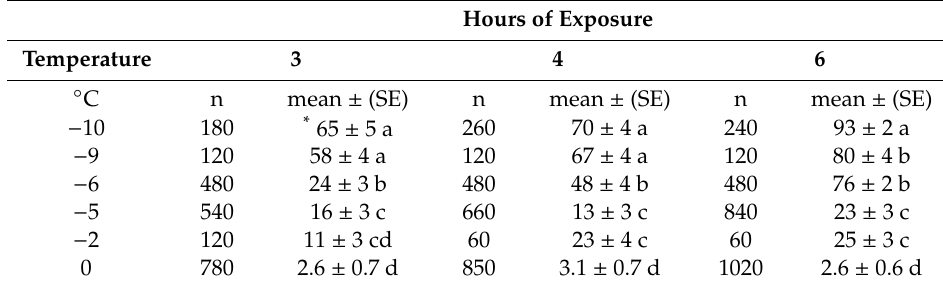
Table 1. Mean percentage mortality of adult lea ff ooted bug after exposure to sub-freezing temperatures for three di ff erent exposure